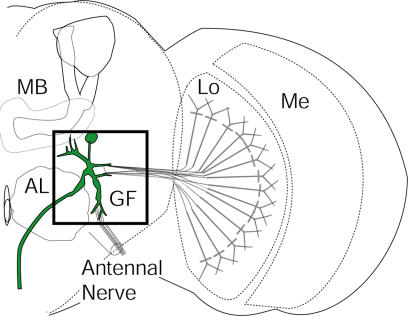
This schematic of the Drosophila brain shows the location of the giant fiber in relation to other brain regions (AL, antennal lobe; GF, giant fiber; Lo, lobula; MB, mushroom body; Me, medulla).